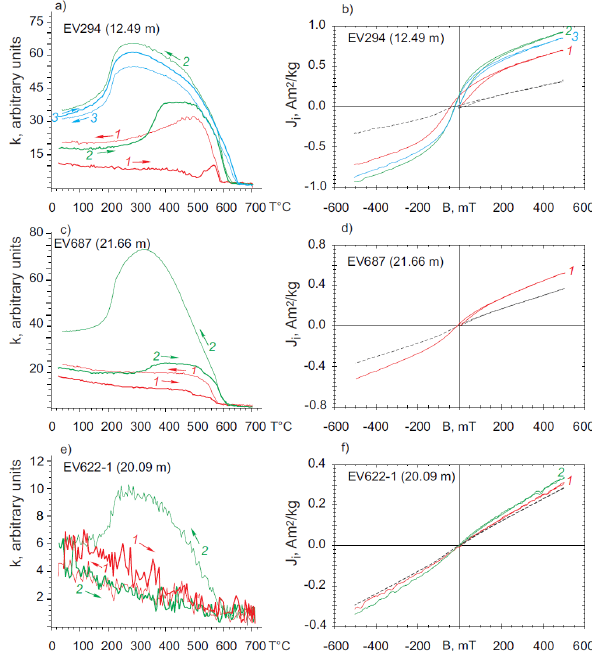
Fig. 7. Susceptibility versus temperature (in air) curves (a, c, e) of representative vivianite samples of groups (the arrows indicate the heating and cooling curves; cursive numbers show the heating and cooling runs) and typical examples of hysteresis loops after heating run (uncorrected for paramagnetism) of vivianite (b, d, f) where dashed line